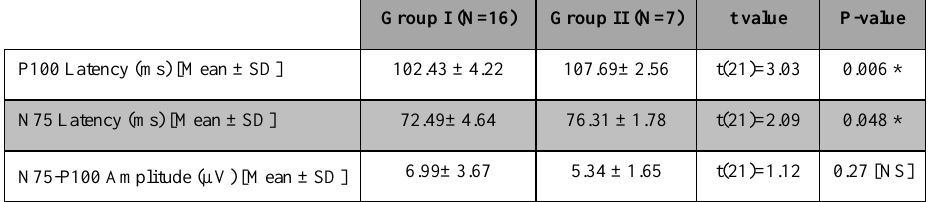
Table 12. Comparison of average VEP wave latencies and the average amplitude of both eyes between group I (having disease duration < 6 years) and group II (having disease duration 6 to 11 years) diabetic